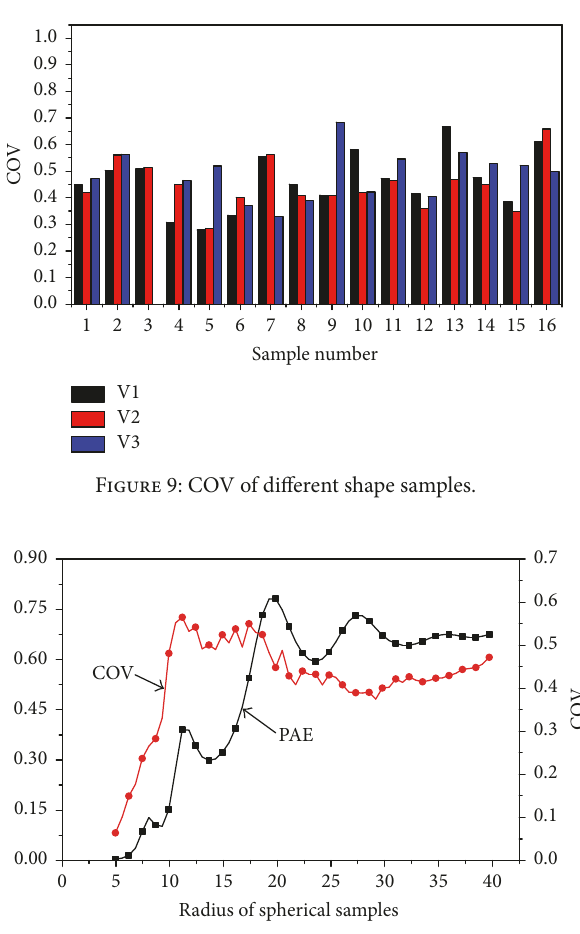
Figure 10: PAE and COV of sphere.